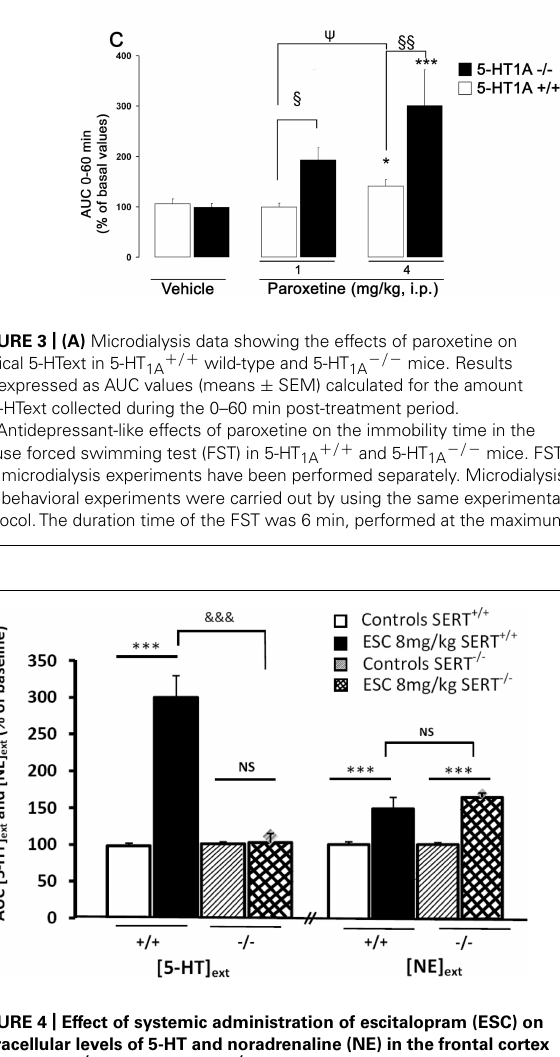
FIGURE 4 | Effect of systemic administration of escitalopram (ESC) on extracellular levels of 5-HT and noradrenaline (NE) in the frontal cortex inWT (SERT + / + ) and KO (SERT –/– ) mice. AUC values (means ± SEM) were calculated for the amount of 5-HT and NE outflows collected during the 0–120 min post-treatment period (from Nguyen etal., 2013). *** p < 0.001 significantly different between controls and escitalopram-treated mice. &&& p < 0.001 significantly different from SERT − / − mice. NS, not statistically